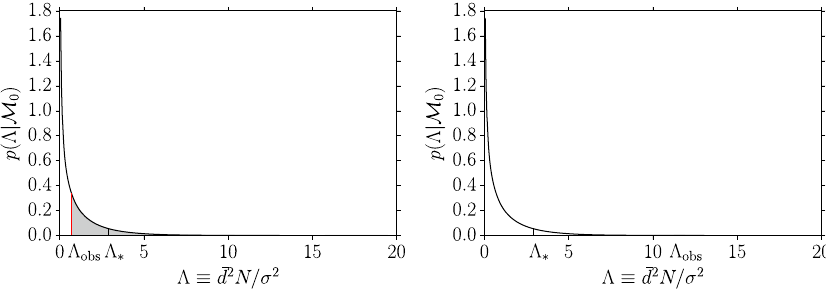
[− 0 . 11 , 0 . 29 ] and [ 0 . 14 , 0 . 54 ] , respectively. These intervals contain the true value